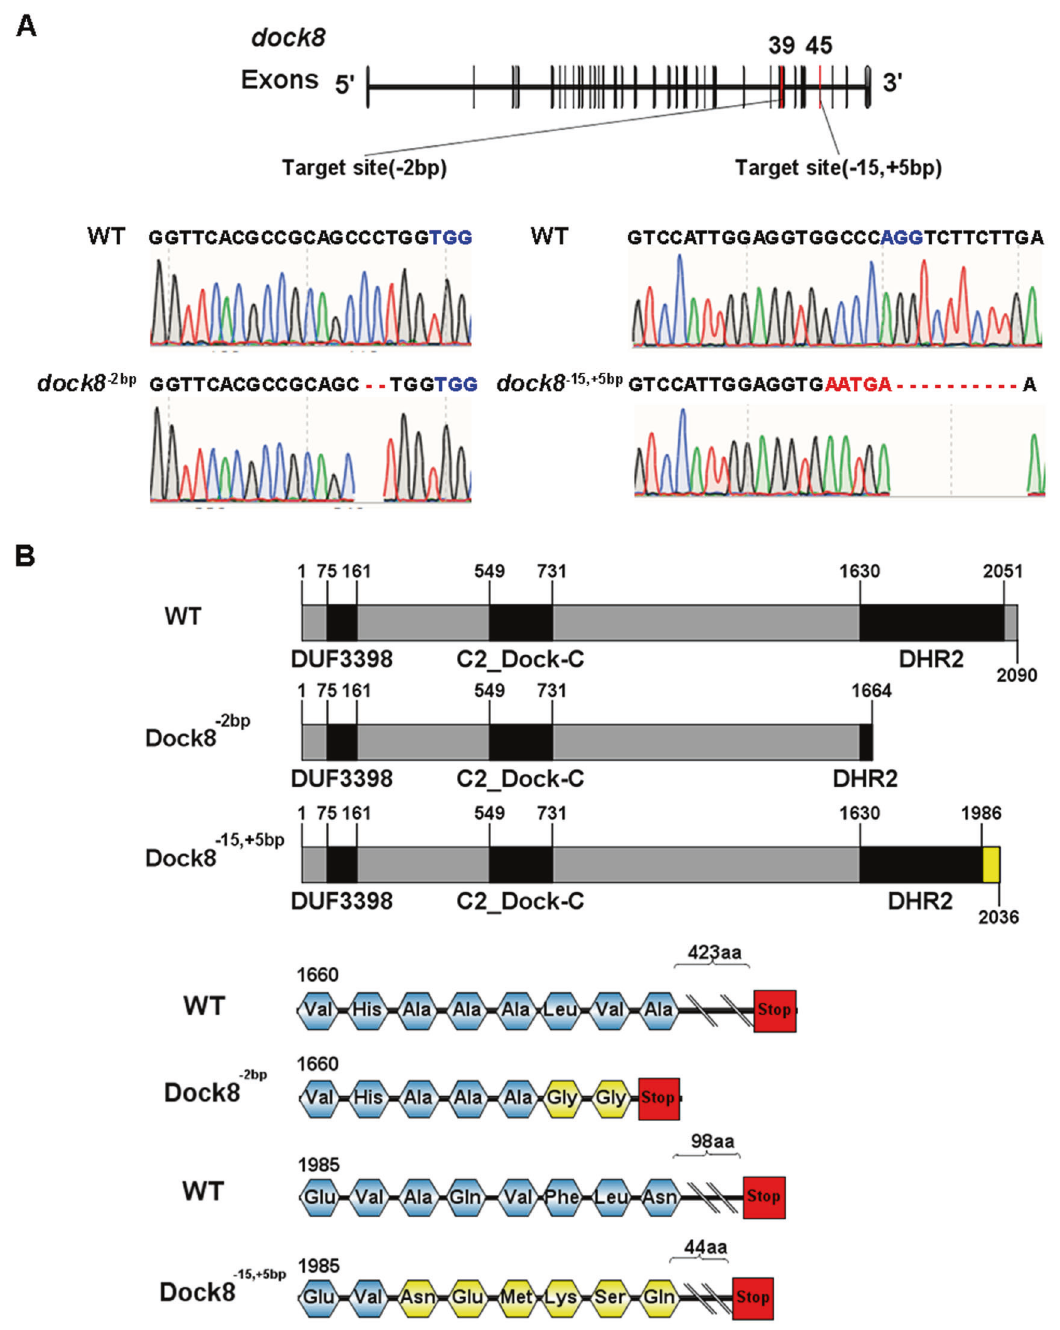
Fig. 1 Generation of dock8 -2bp and dock8 -15, + 5bp mutants. A Sequencing results of the deletion and insertion in dock8 -2bp and dock8 -15, + 5bp mutants. Both mutants were generated by CRISPR/Cas9. gRNA targeted at exon 39 and caused 2 bp deletion. gRNA targeted at exon 45 causing 15 bp deletion and 5 bp insertion. PAM sequence was highlighted in blue. Insertion and deletion were highlighted in red. B Modular structure of WT and truncated protein. Altered amino acids were labeled in